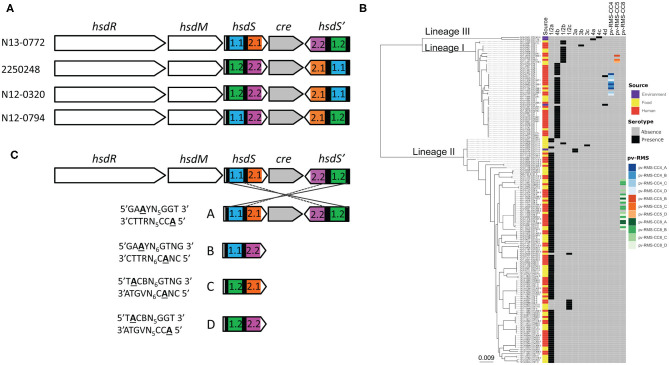
The phase variable Lmo0320I RMS in L. monocytogenes CC4. The locus of the Lmo0772I RMS is composed of an operon containing the co-transcribed hsdR (restriction subunit), hsdM (methylation subunit) and hsdS (specificity subunit) genes, a site-specific recombinase (gray), and a further inactive hsdS gene without a proper start codon and no promoter. The alignment of the locus for the phase variable RMS from four Swiss ST4 CC4 isolates indicates how recombination on the inverted repeats within the hsdS genes (black bars) is able to shuffle the target recognition domains TRD1.1 (blue), 1.2 (green), 2.1 (orange), and 2.2 (pink) (A). To investigate the phylogenetic context all L. monocytogenes phase variable RMSs were mapped on a core-genome phylogenetic tree of 160 Swiss L. monocytogenes isolates (Zamudio et al., 2020). The color of the squares in the heat map are linked to the source (human in red, food in yellow and environment in purple), serotype (presence in black and absence in gray) and phase variable RMS (pv-RMS-CC4 in blue, pv-RMS-CC5 in orange and pv-RMS-CC8 in green. The active variant (A, B, C, or D) of each pv-RMS is indicated by a different shading. (B) Rearrangements within the locus generate the four possible hsdS alleles, A–D by creating different combinations of TRDs 1.1 (blue), 1.2 (green), 2.1 (orange) and 2.2 (pink). Each TRD combination results in an alternative methylation pattern of the genome. These methylation patterns were determined by SMRT sequencing and are shown to the left of each hsdS allele (C).